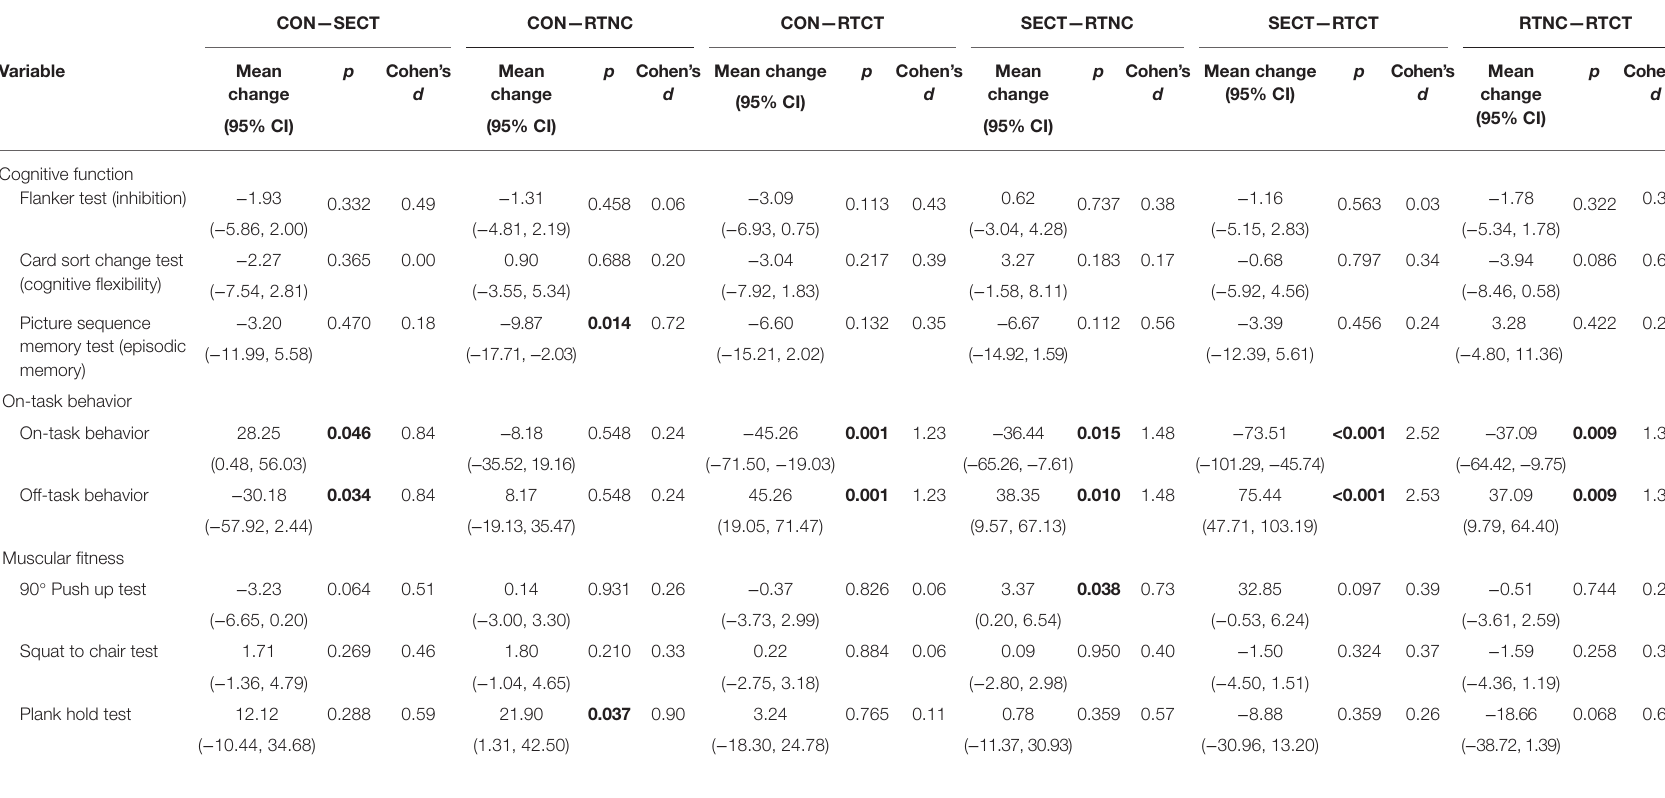
TABLE 3 | Adjusted difference between groups (post-test—baseline). CON—SECT CON—RTNC